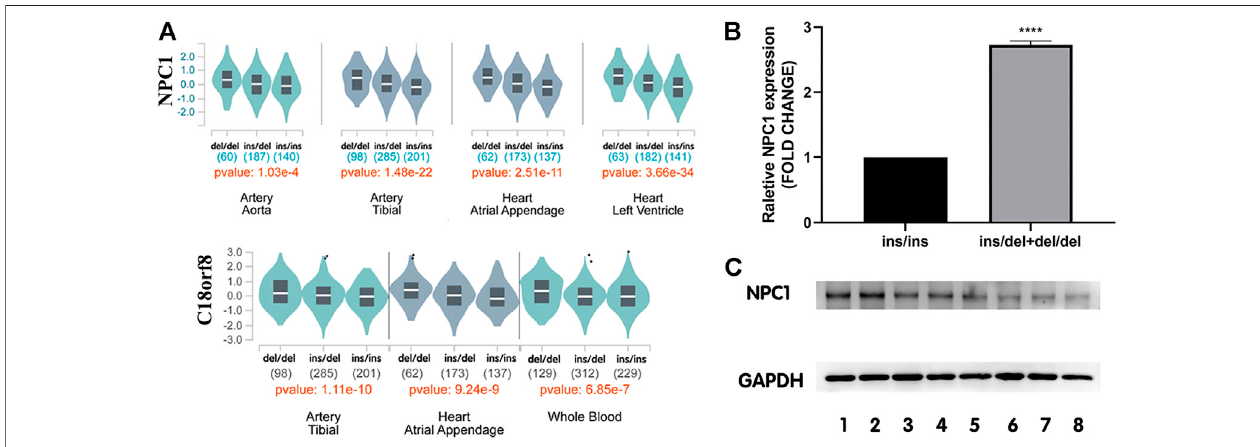
FIGURE 4 | Expression levels of NPC1 in human tissues among different genotypes. (A) Genotype-expression analysis between rs150703258 and mRNA expression in human heart, arteries and whole blood samples in GTEx database. (B) The mRNA level of NPC1 in human myocardium samples showed that in tissues withins/del and del/del genotype was2.73-foldhigher than that insampleswithins/insgenotype. (**** p < 0.0001). ins/ins, N =6, ins/del and del/del, N= 9. (C) Western blot assay analysis of NPC1 at protein level. Lanes 1 – 2 represent del/del genotype, and lanes 3 – 5 represent ins/del genotype, and lanes 6-8 represent ins/ins